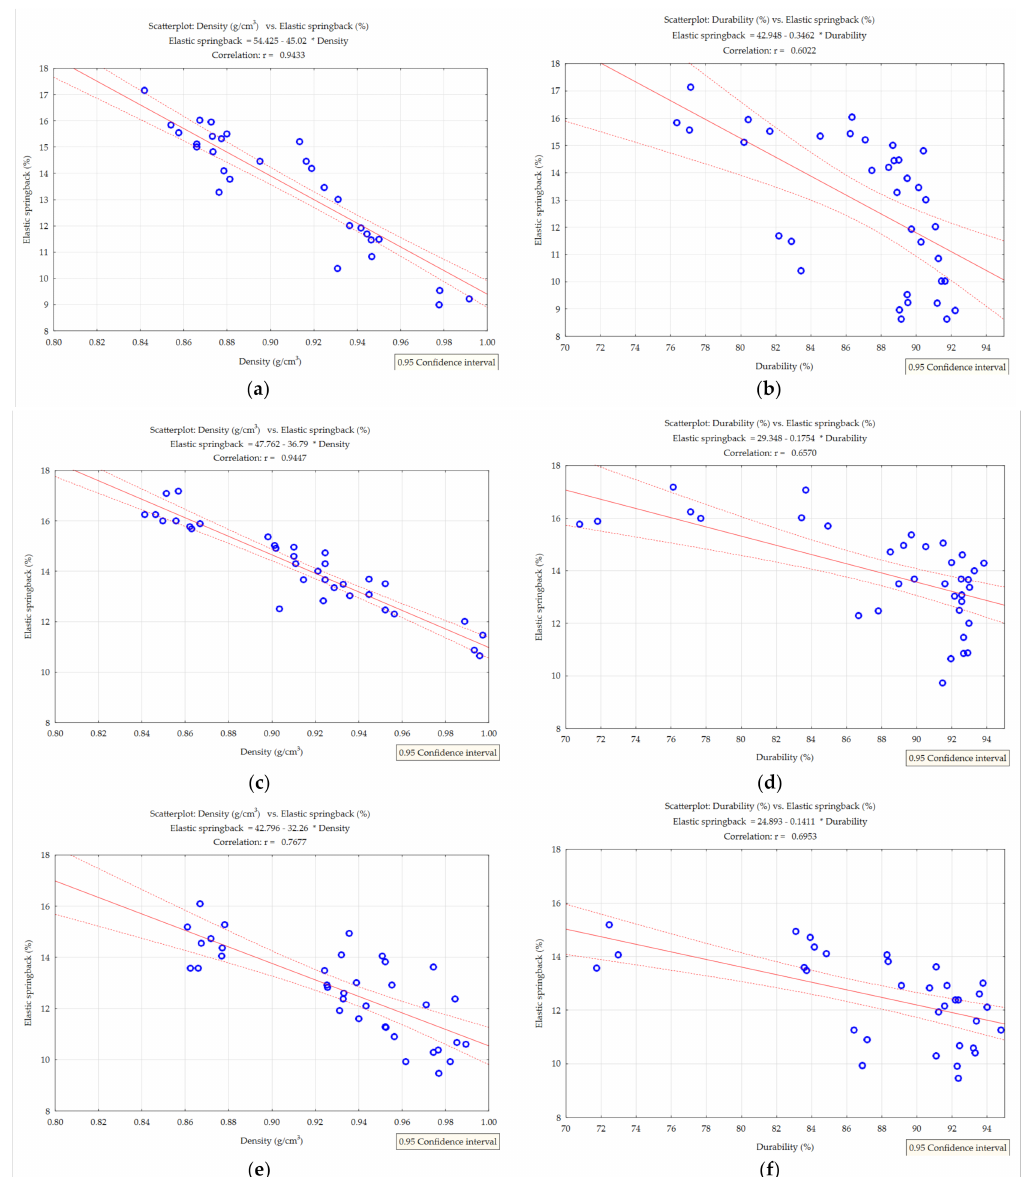
Figure 11. Correlation values. ( a ) Elastic springback vs. density—miscanthus, ( b ) elastic springback vs. durability— miscanthus, ( c ) elastic springback vs. density—silphium, ( d ) elastic springback vs. durability—silphium, ( e ) elastic springback vs. density—sida, and ( f ) elastic springback vs.